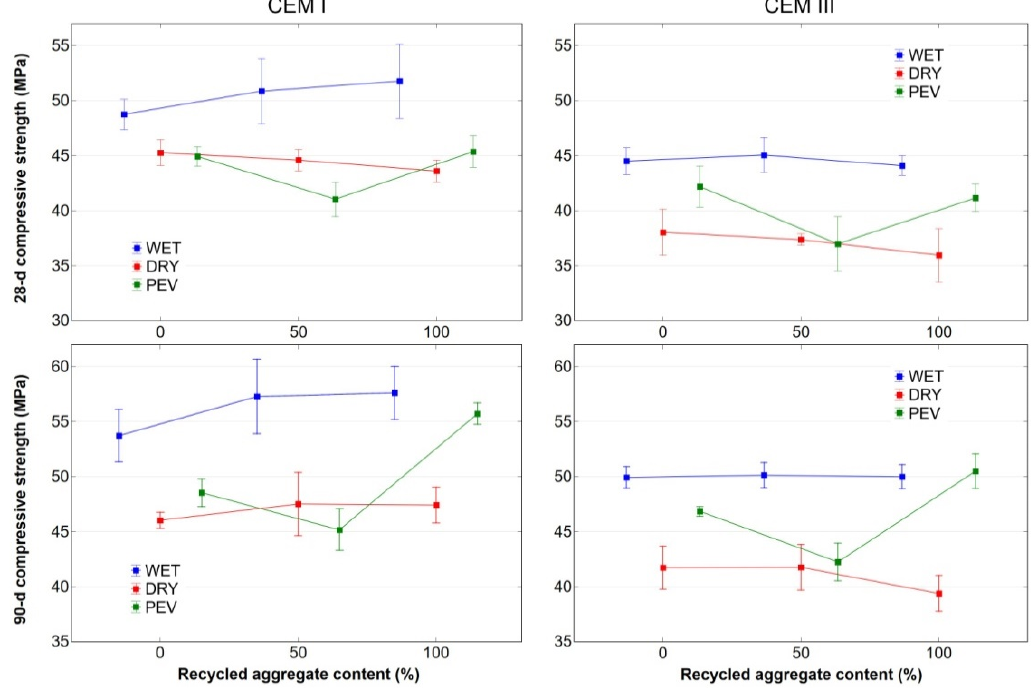
Figure 4. Compressive strength of concrete after 28 and 90 days.